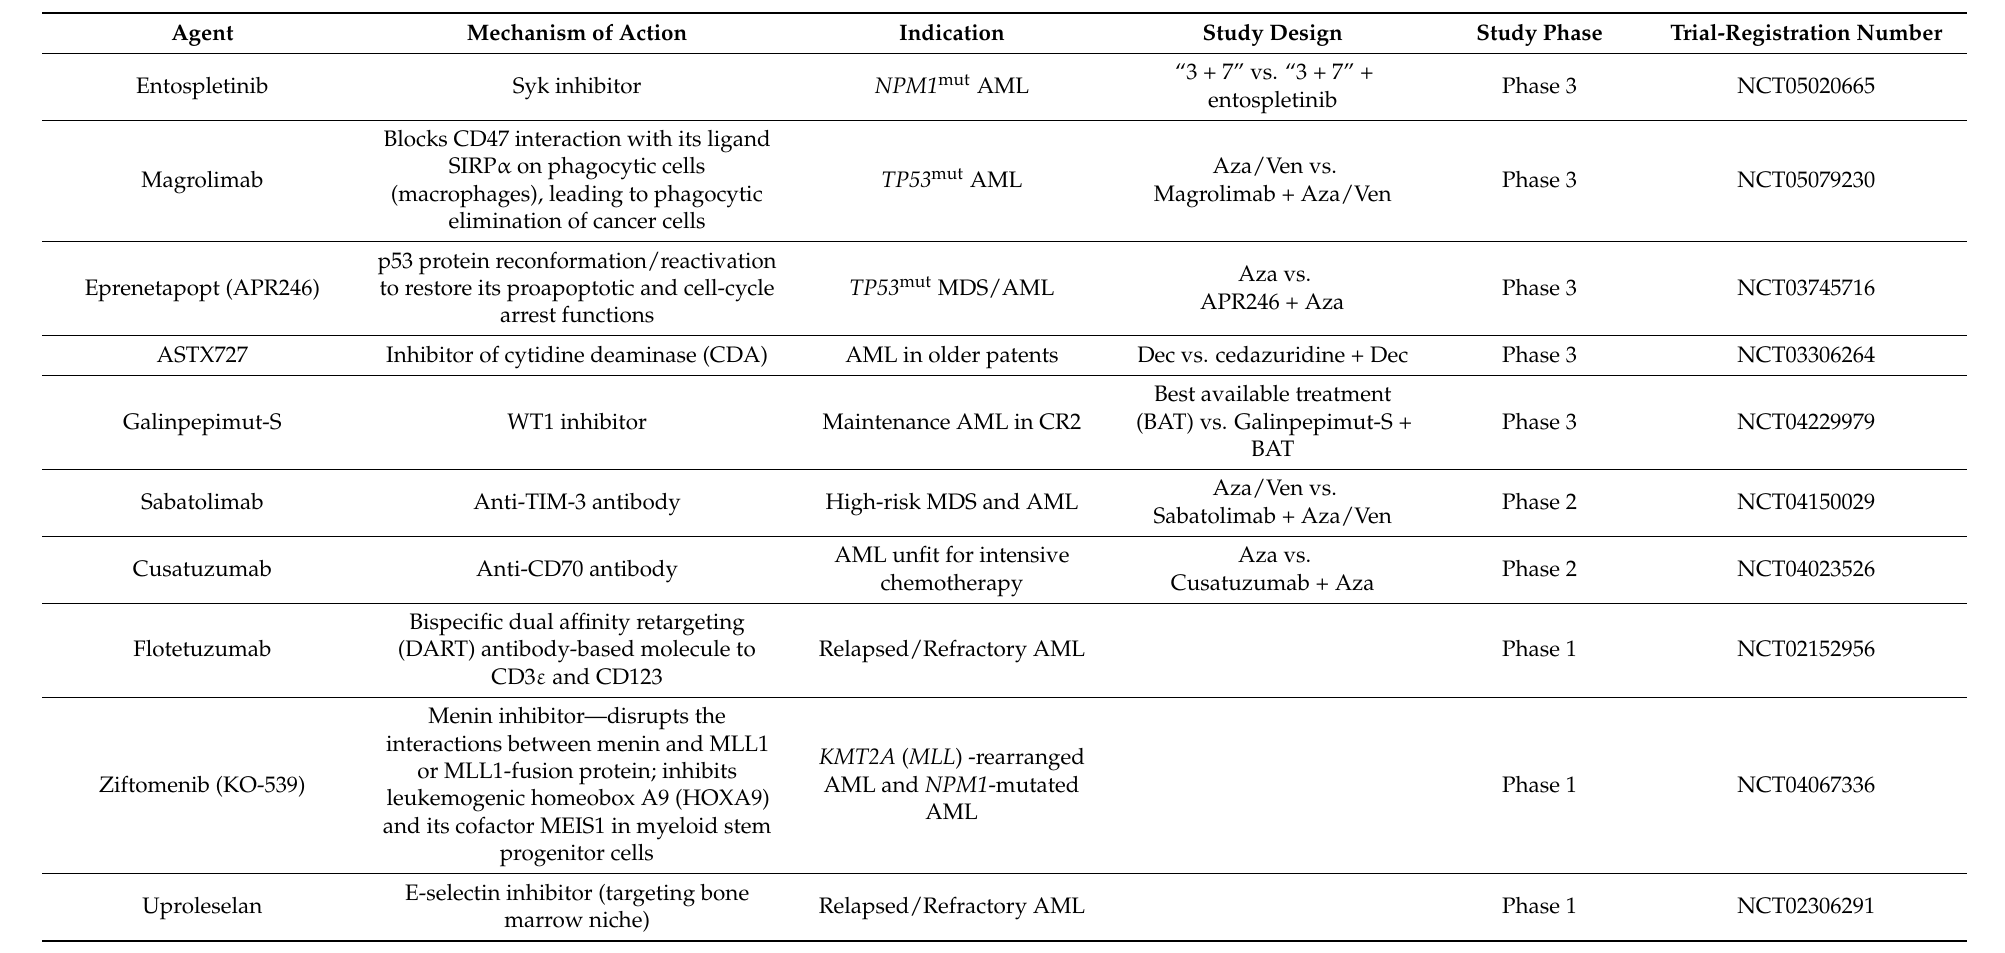
Table 4. Selected newer agents in clinical development for the treatment of AML including patients with therapy-related